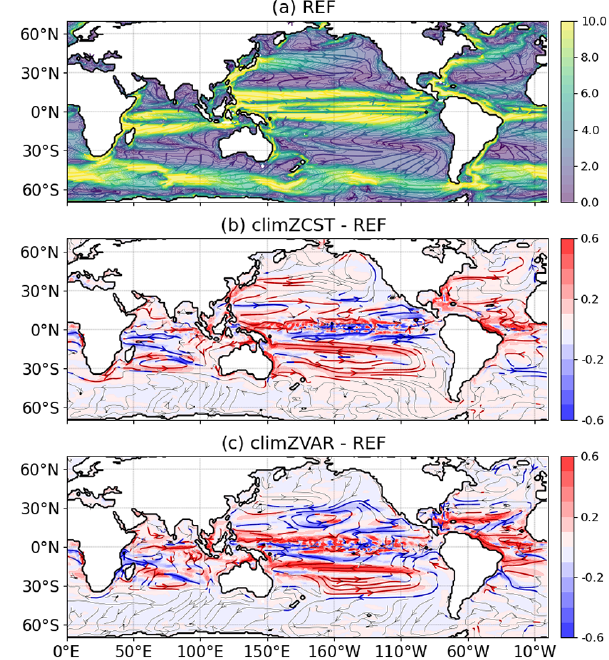
Figure 4. Annual mean speed (colour; cms − 1 ) and streamlines of oceanic currents between 0–300m over the 2009–2018 period for (a) REF and its differences in relation to (b) climZCST and (c) climZVAR. In (b) and (c) , streamlines are coloured when absolute speed are larger than 0.05cms − 1